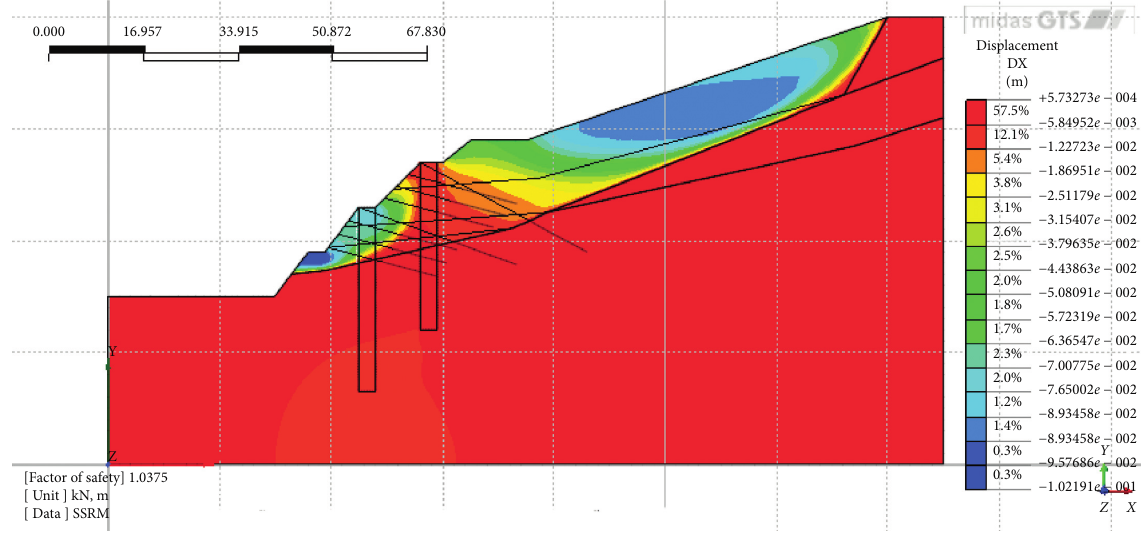
Figure 7: Horizontal displacement of the formation after construction of the initial support.